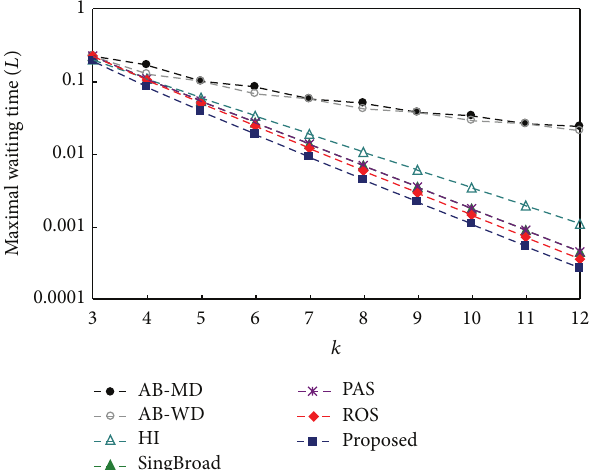
Figure 4: Maximal waiting time (in terms of L ) incurred on new clients at different broadcasting